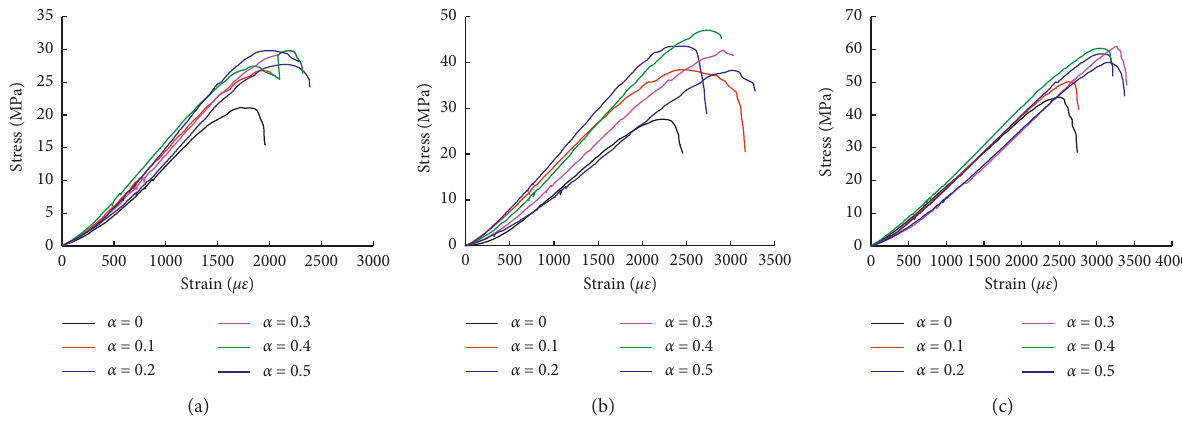
Figure 5: Biaxial compression-compression stress-strain curves of plain concrete. Ordinary concrete: (a) C30; (b) C40; (c) C50.